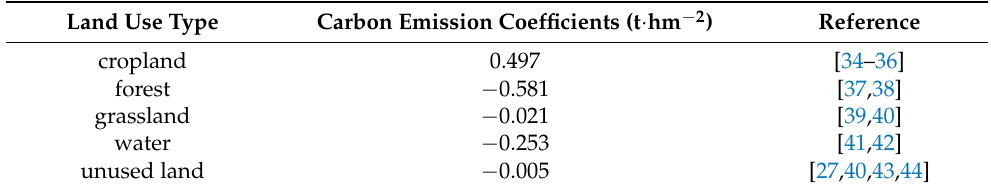
Table 1. Carbon emission coefficients and literature sources for each land use